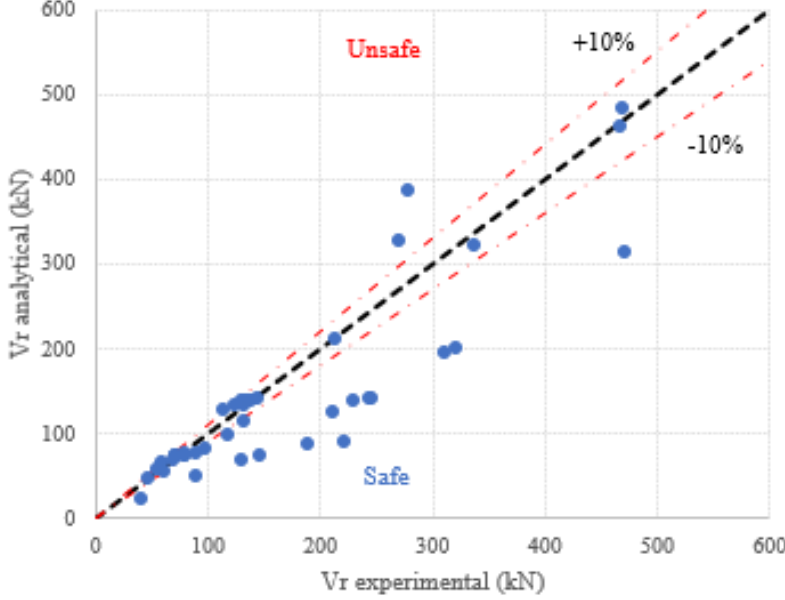
Figure 8. Residual shear force: analytical vs.